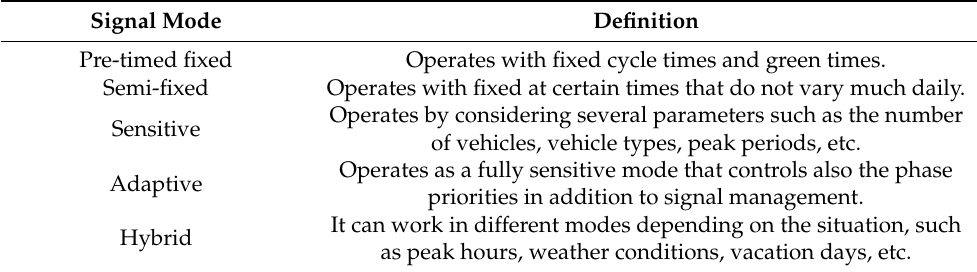
Table 1. Definitions of the signal plans.